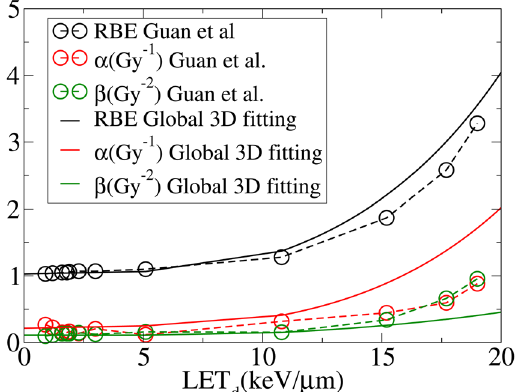
Figure 8. α , β , and RBE as a function of LET calculated by the conventional method and the presented 3D global fitting method. Although the difference in RBE between the two methods is negligible, the α and β are significantly different (H460 cells).